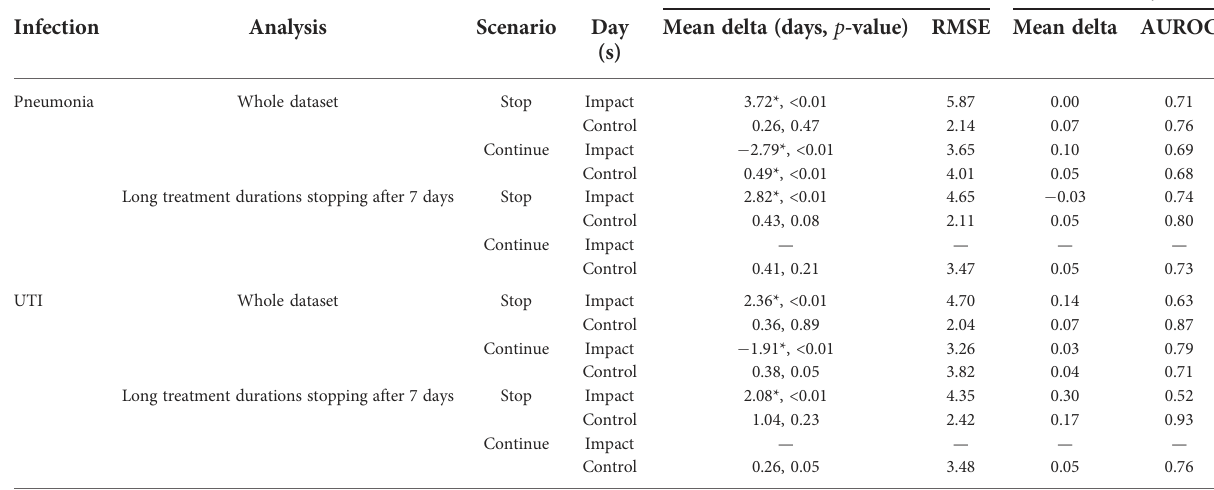
TABLE 3 Outcome estimation results for patients with pneumonia and